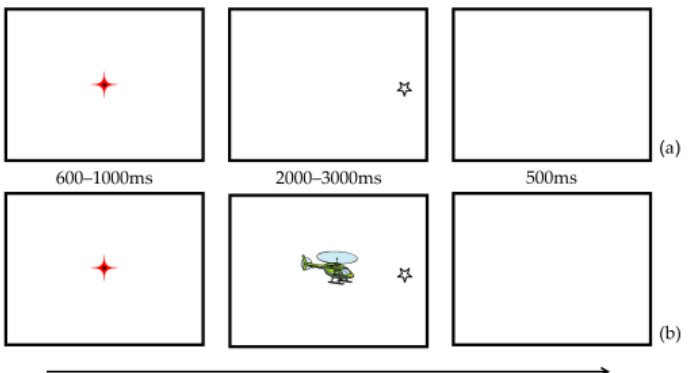
Figure 4. Schematic examples of the MGOP task in the baseline condition ( a ) and overlap condition ( b ) of Experiment 3. The helicopter picture represents a CI-related item.